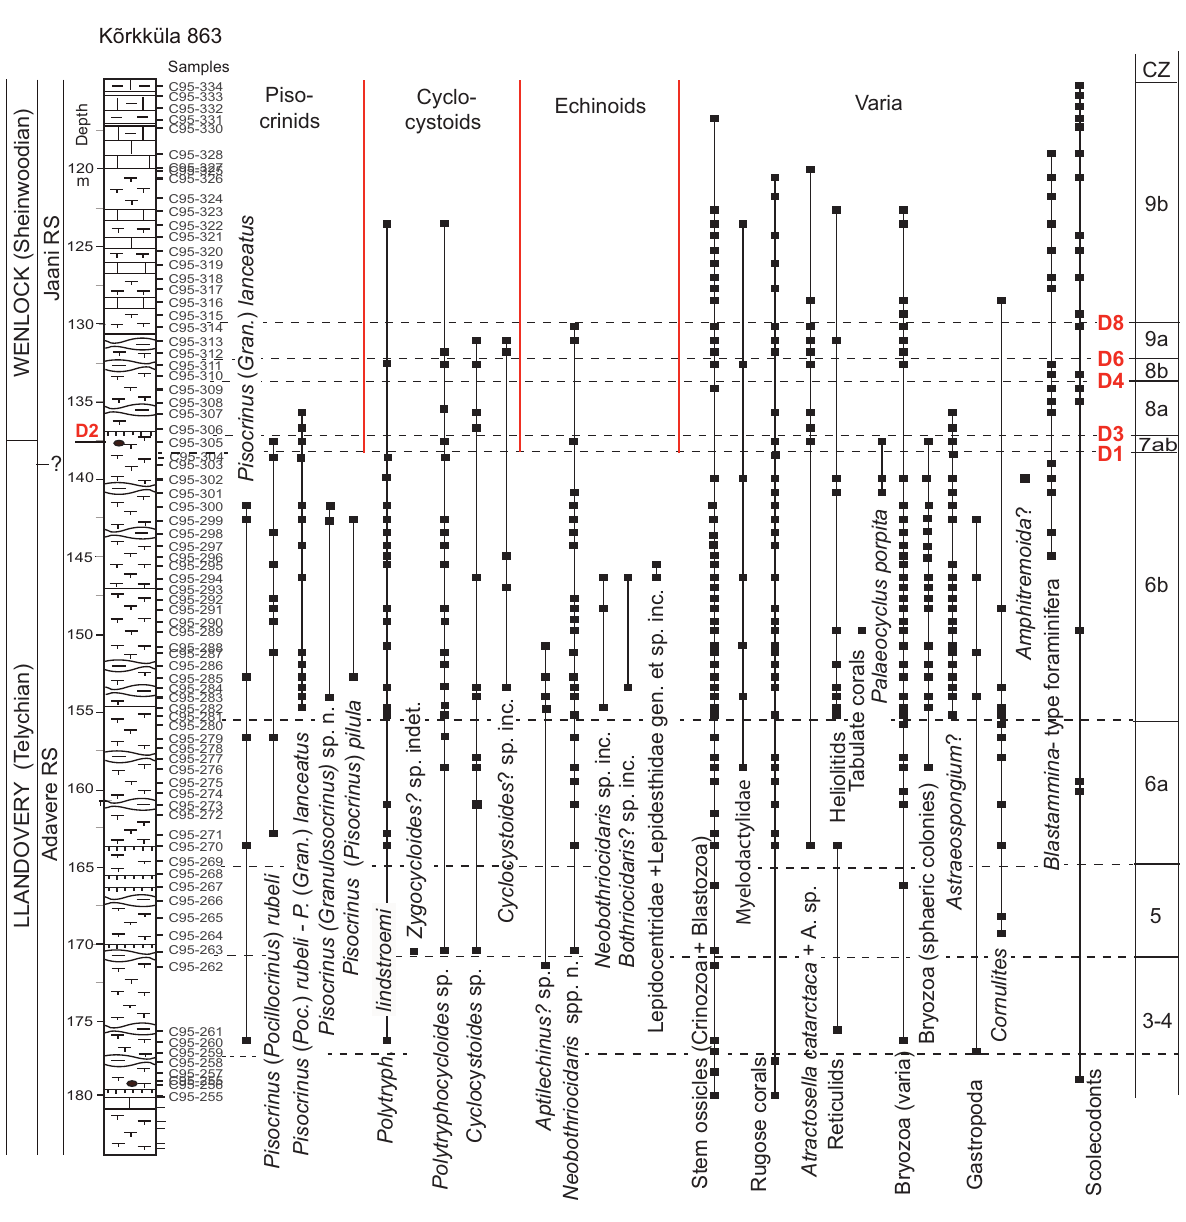
Fig. 8. Distribution of echinoderms and selected fossils (“Varia”) identified at different taxonomic levels in the Kõrkküla 863 section. For the legend and explanation of indexes, see Figs 2 and